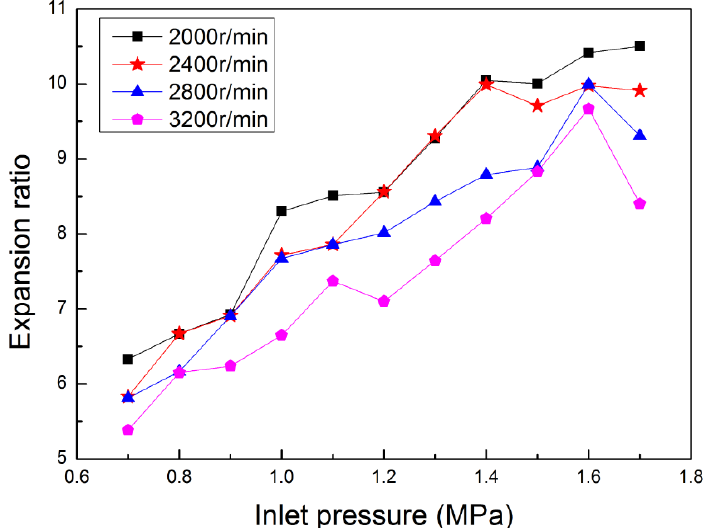
Figure 6. Variation of expansion ratio with the inlet